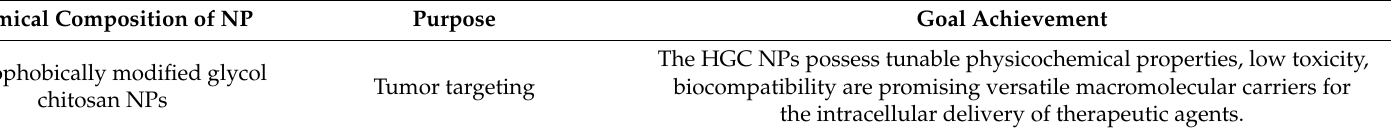
Table 3. Applications of NPs coated with specific corona to achieve particular